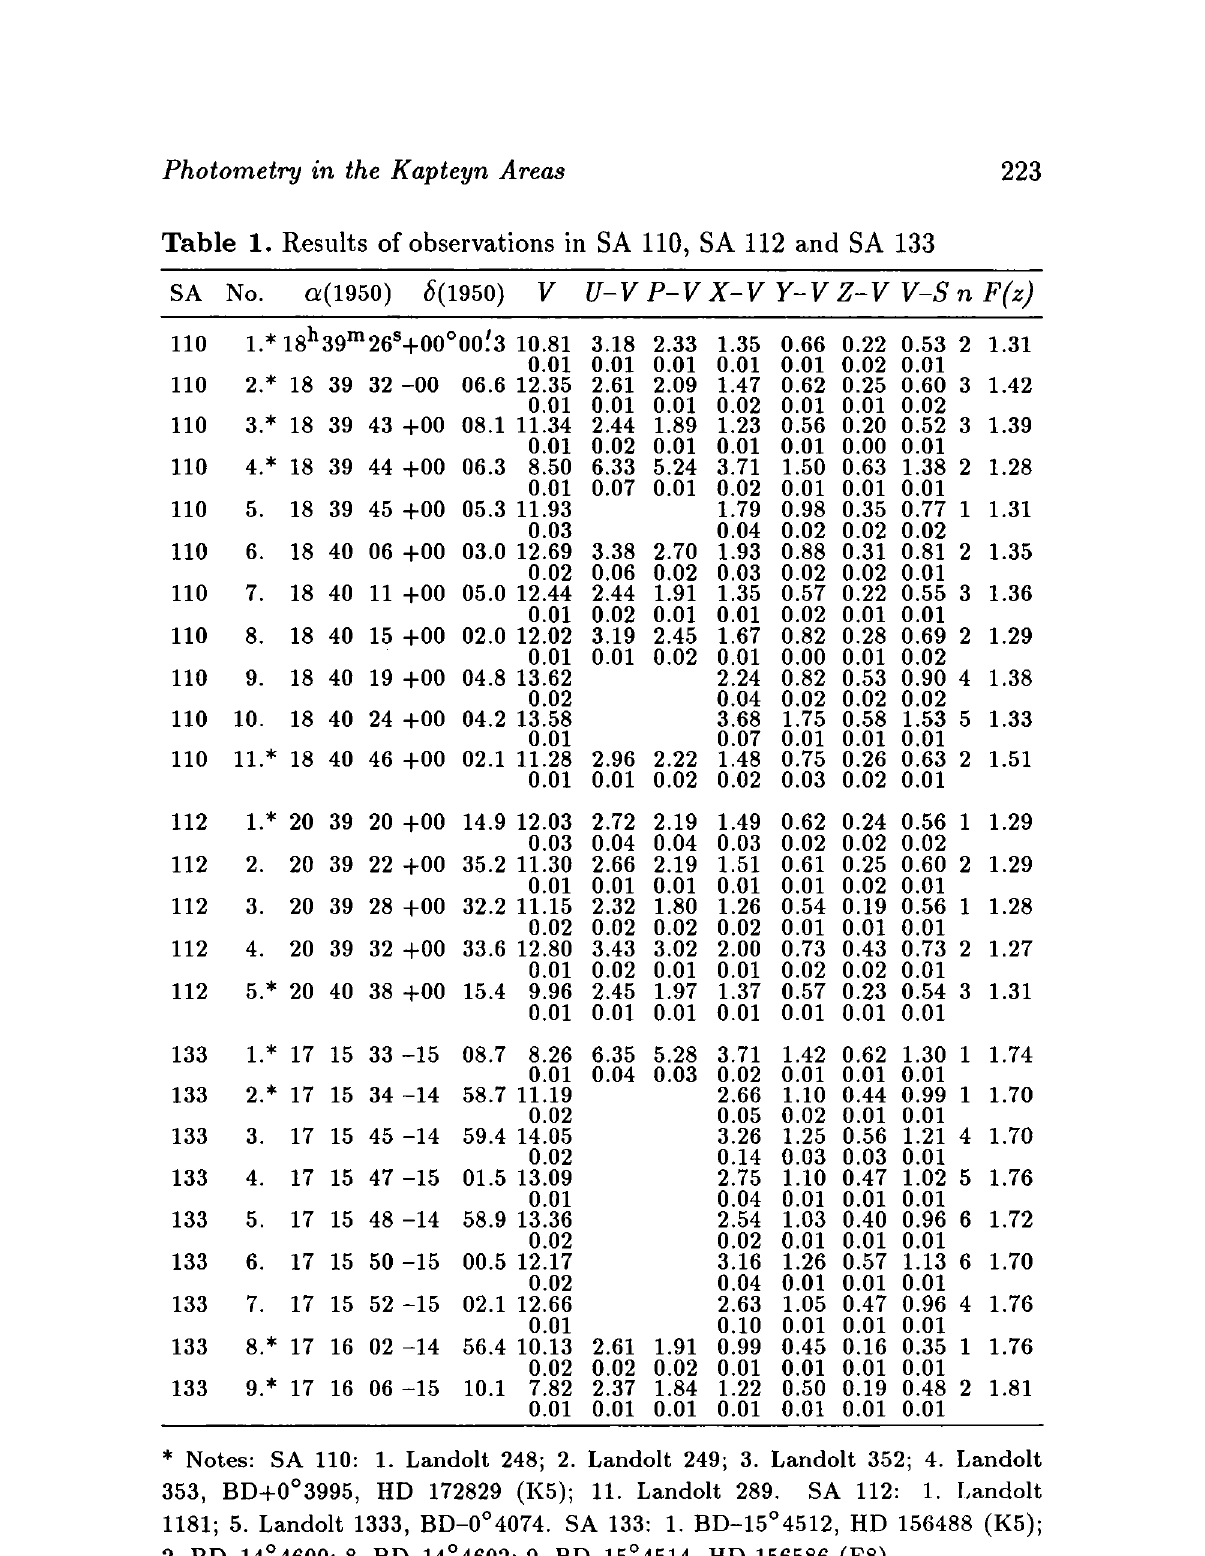
Table 1. Results of observations in SA 110, SA 112 and SA